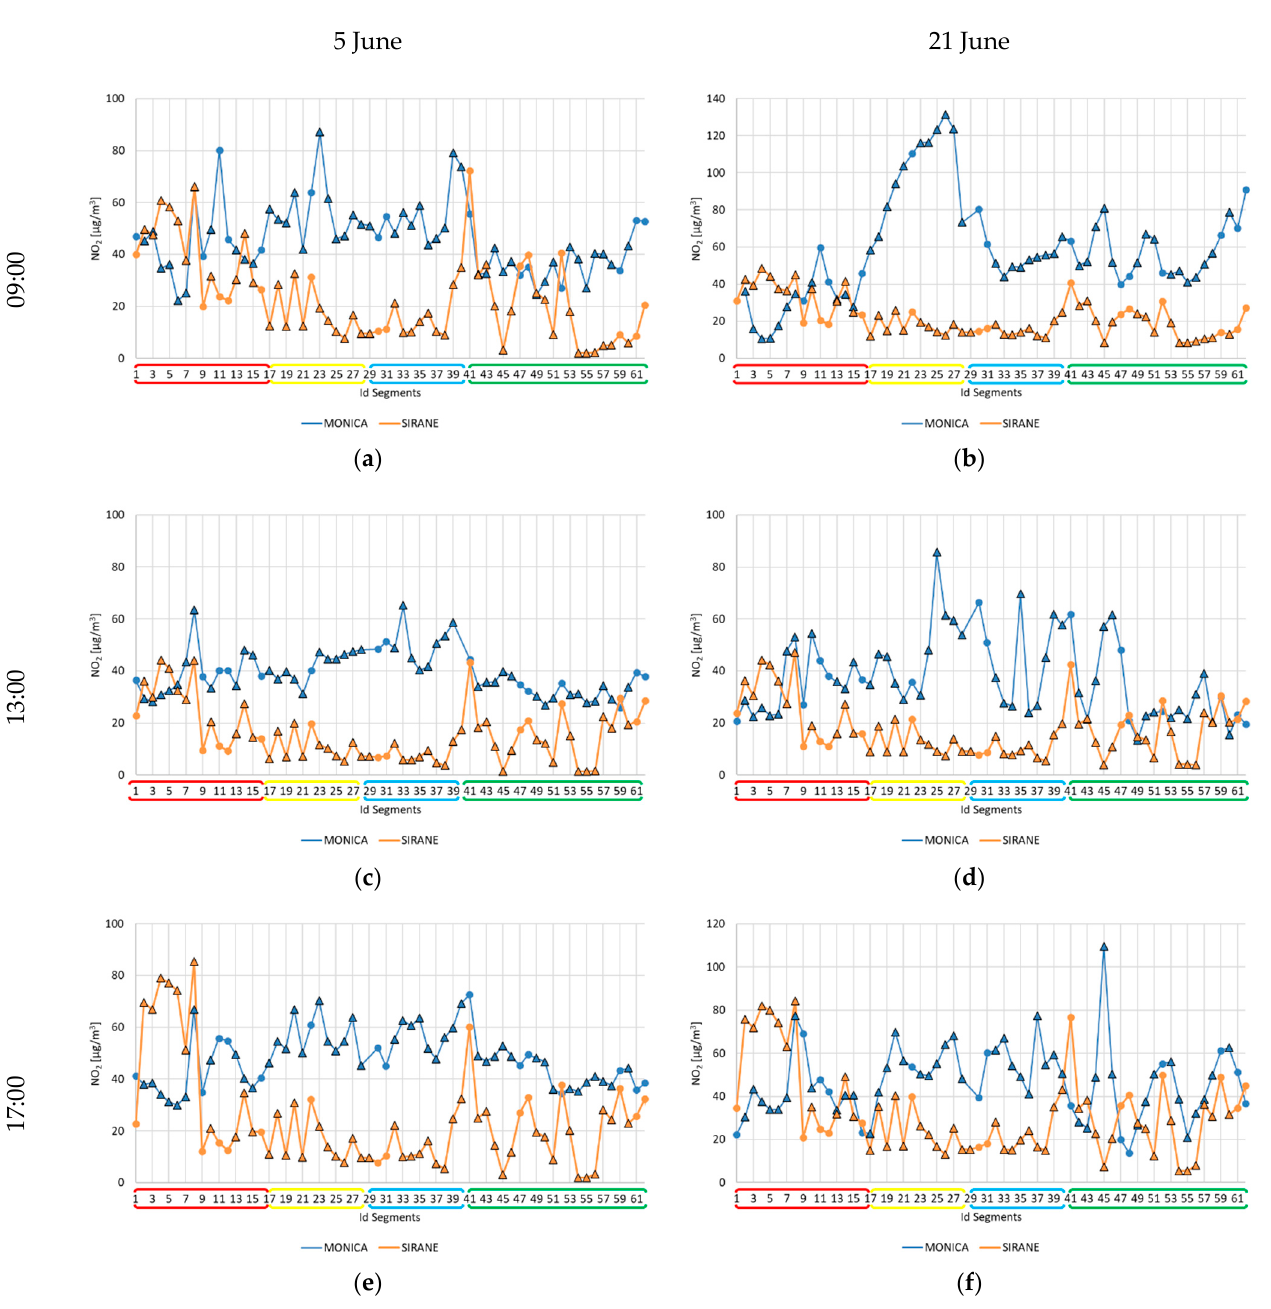
Figure 10. Comparison between MONICA (blue line) and SIRANE (orange line), for NO 2 pollutant: ( a ) at 9 am on 5 June; ( b ) at 9 am on 21 June; ( c ) at 1 am on 5 June; ( d ) at 1 am on 21 June; ( e ) at 5 pm on 5 June; ( f ) at 5 pm on 21 June. Triangles are street canyons and circle open roads. The ID receptors from 1 to 16 (red lines) are referred to the road segment Corso Garibaildi; IDs from 17 to 28 (yellow lines) to the road segment Via Libertà ; IDs from 29 to 40 (blue lines) to the road segment Via DaVinci; IDs from 41 to 61 (green lines) to the road segment Via Diaz.